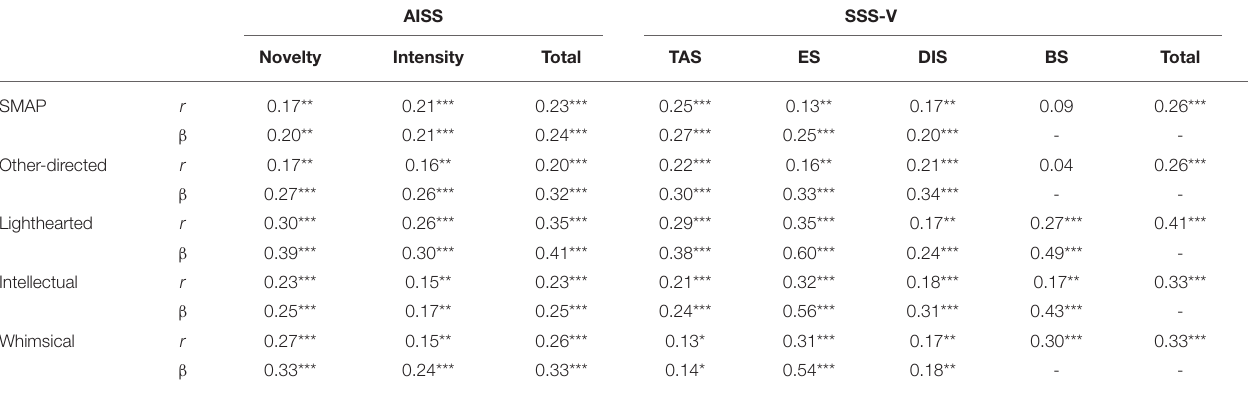
TABLE 4 | Associations between playfulness and sensation-seeking scales in 399 police officers in correlation ( r ) and SEM analyses ( β ).